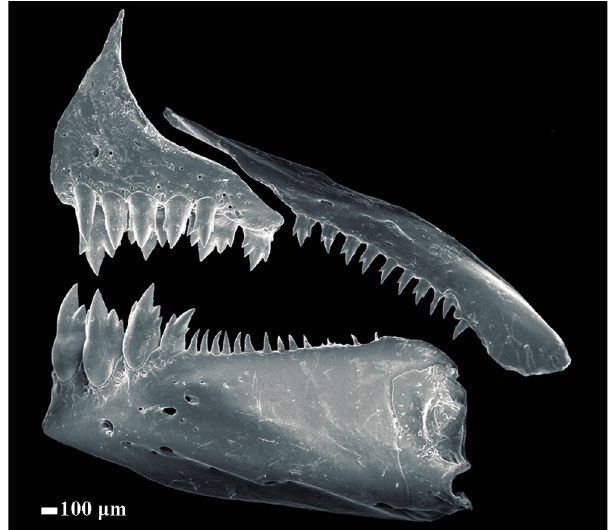
Fig. 2. Boehlkea weitzmani , INPA 48541, 32.8 mm SL, paratype. Scanning electron micrograph of left side upper and lower jaws. Scale bar = 100μm. Color in alcohol. Overall ground color of body pale yellow.